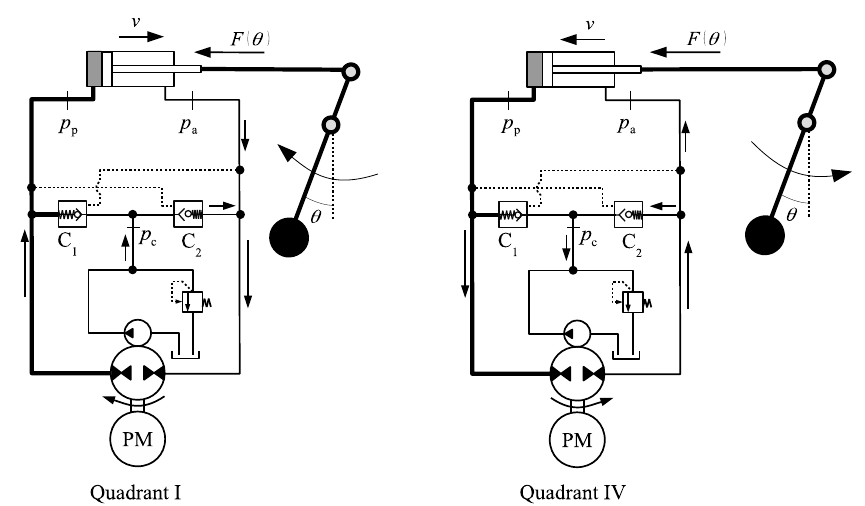
Figure 15. External force on the cylinder rod (first and fourth quadrants).